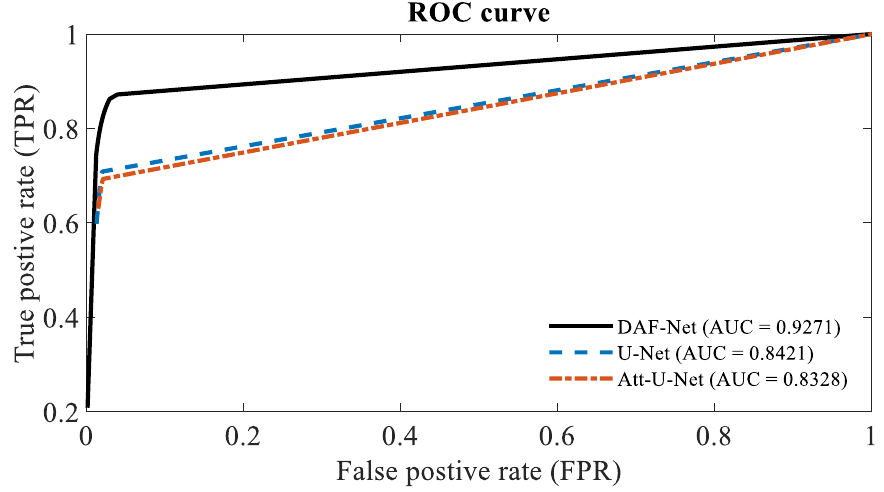
Figure 5. ROC curves for the three different networks (U-Net, Att-U-Net, and